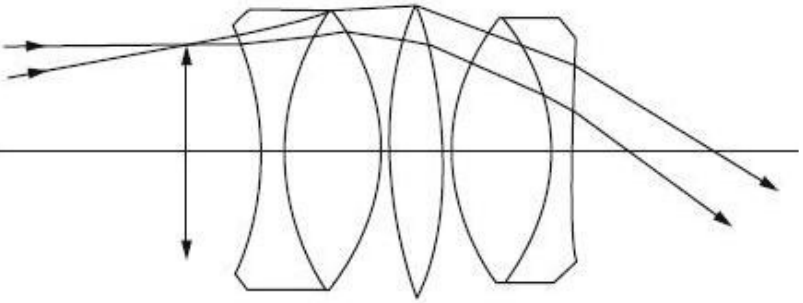
Figure 5. Construction of an Erfle eyepiece [29].